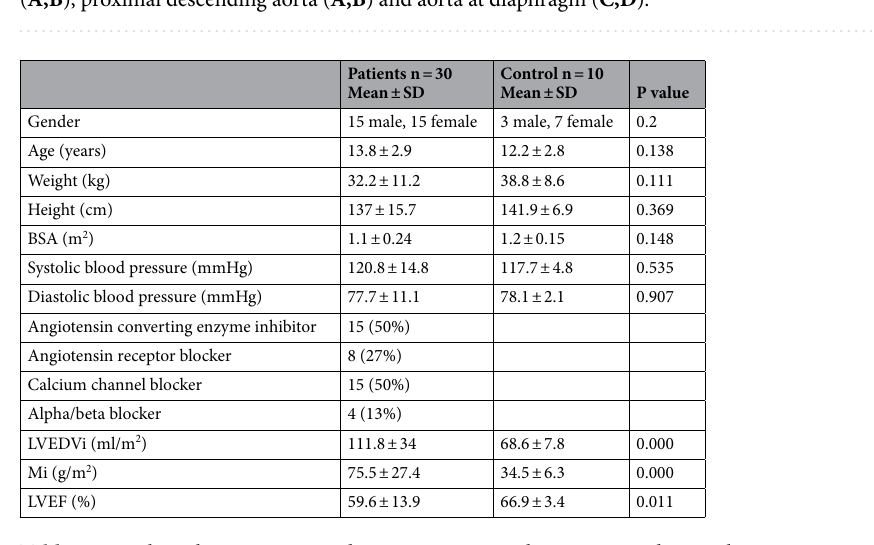
Table 1. Baseline characteristics and LV parameters in the patients and control groups.